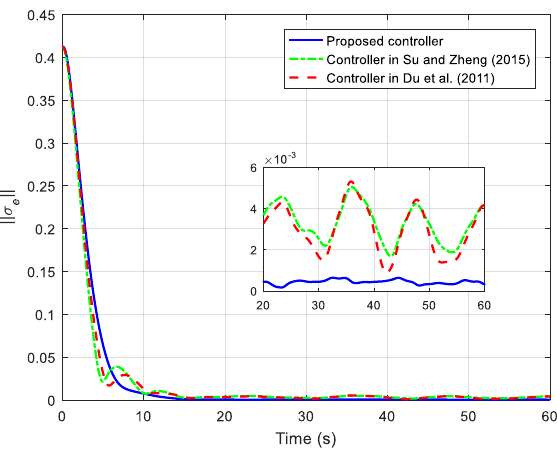
Figure 8. Norm of the attitude tracking errors (cid:107) σ e (cid:107)